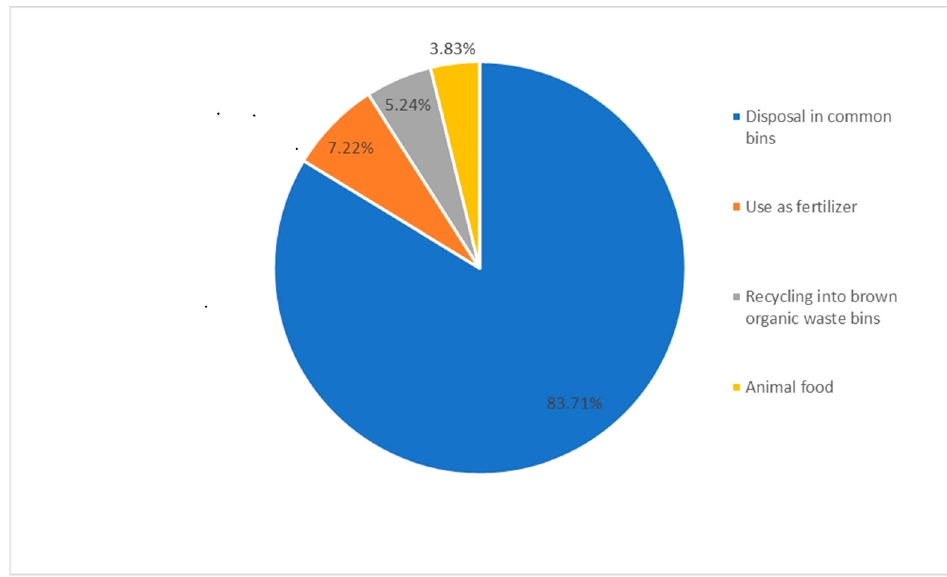
Figure 5. Responses to the question, “Which is your method to reject your food waste?”